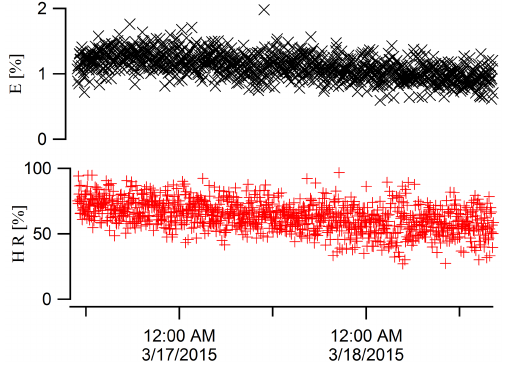
Figure 2. Repeatability of the scattering efficiency ( E ) and the hit rate (HR), during a time period of 53h.